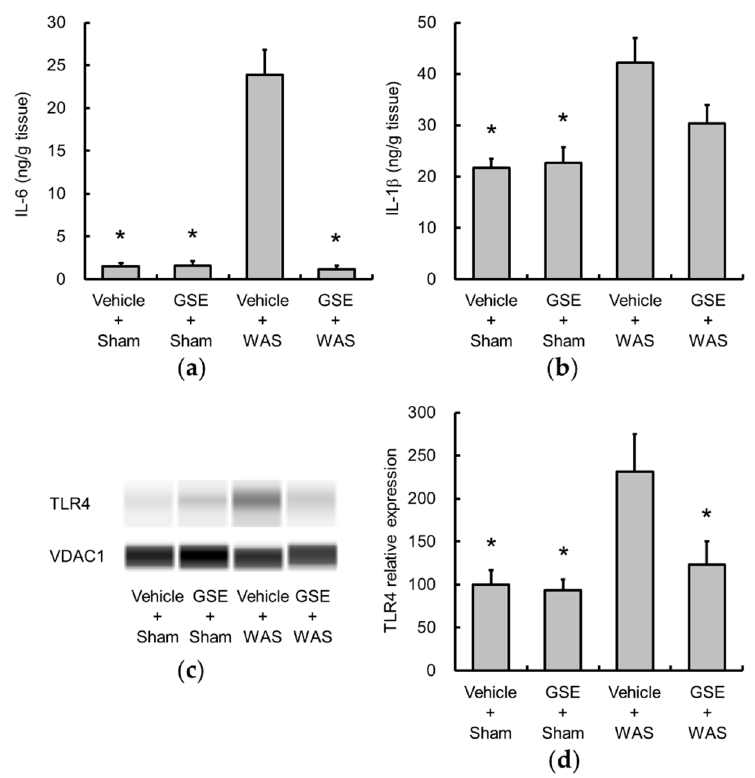
Figure 3. Effect of GSE on WAS-induced colonic proinflammatory cytokine and TLR4 changes. The production of IL-6 ( a ) and IL-1 β ( b ) was determined by enzyme-linked immunosorbent assay, and TLR4 ( c, d ) protein expression was evaluated by capillary western blot and normalized by VDAC1. The levels of IL-6 ( a ), IL-1 β ( b ) and TLR4 ( d ) were elevated by WAS, and GSE suppressed the increases in IL-6 and TLR4. Representative images are shown ( c ). Data are presented as the mean ± S.E.M ( n = 6–7). * p < 0.05 vs. Vehicle + WAS group. GSE, grape seed extract, IL, interleukin, TLR4, toll-like receptor 4, VDAC1, Voltage-dependent anion-selective channel 1, WAS, water avoidance